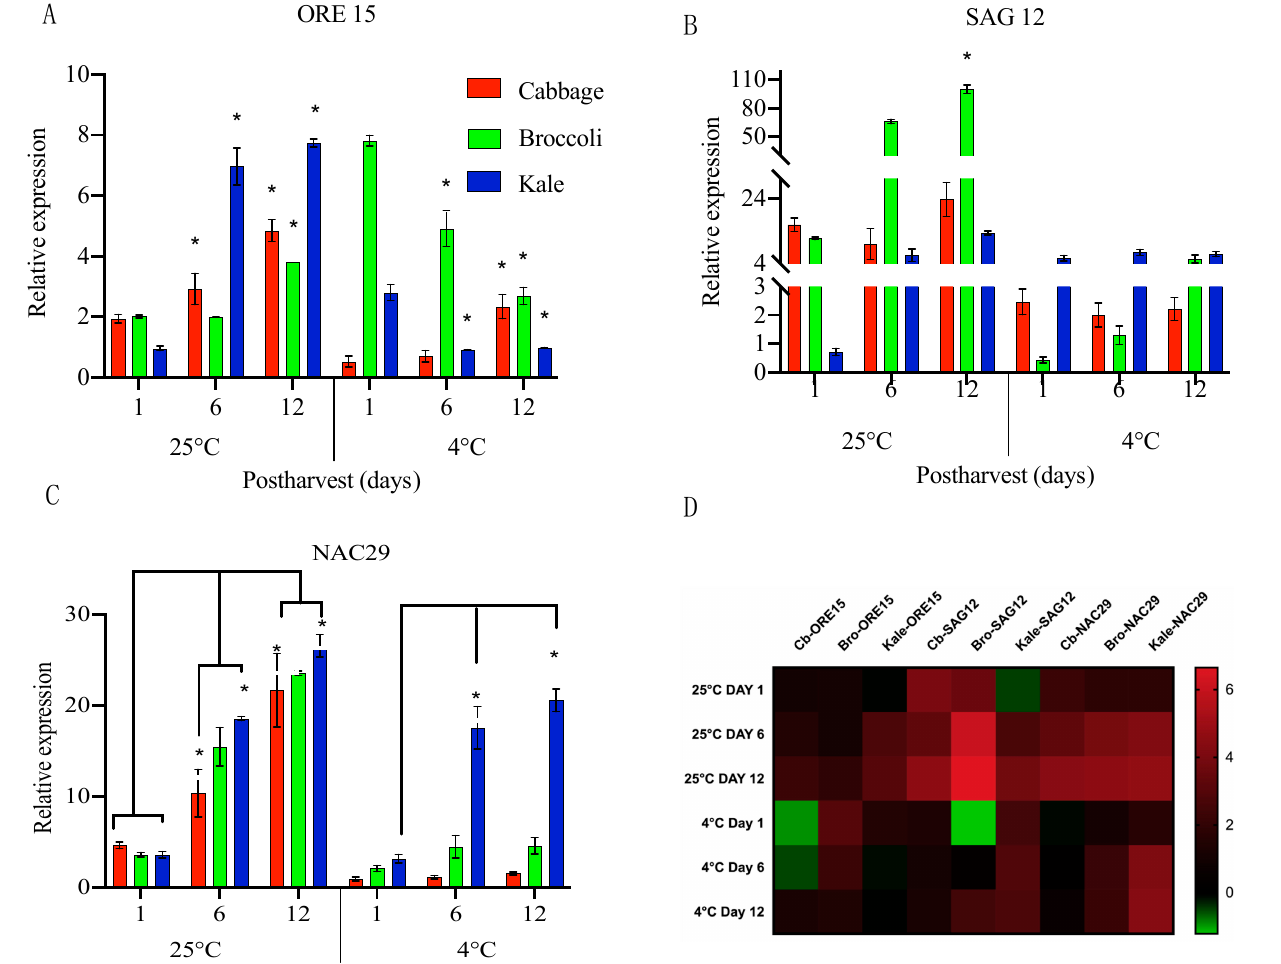
Figure 3. Relative expression of senescence-associated genes ORE15 ( A ), SAG12 ( B ), and NAC29 ( C ) in cabbage leaves (red), broccoli (green), and kale (blue) stored at 25 ◦ C and 4 ◦ C for 12 days. ( D ) Effect of storage temperature (25 ◦ C and 4 ◦ C) on selected SAGs represented as heap maps. Fold change is expressed as log 2 ratio of transcript levels represented in the form of colors. Red color indicates upregulation and green color indicates downregulation. The heat map was constructed using graph-pad prism 8.4 software with the normalized expression profiles. Data represent means ± SE bars ( n = 3 leaves for each day). Asterisks (*) if any indicate statistically significant differences from day 1 (control) to treated samples (day 6 and day 12) for each time point ( p < 0.05).